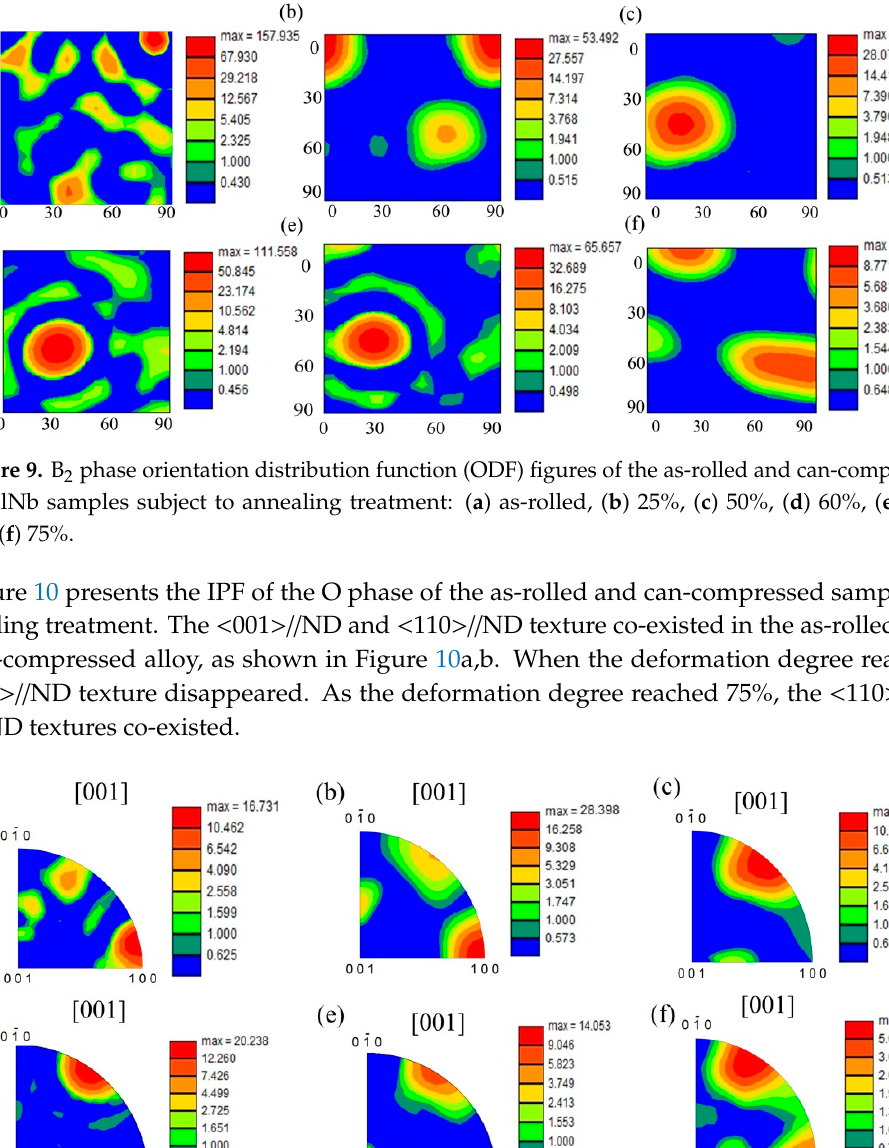
Figure 8. B 2 phase IPF of the as-rolled and can-compressed Ti 2 AlNb samples subject to annealing treatment: ( a ) as-rolled, ( d ) 25%, ( c ) 50%, ( d ) 60%, ( e ) 65%, and ( f ) 75%.